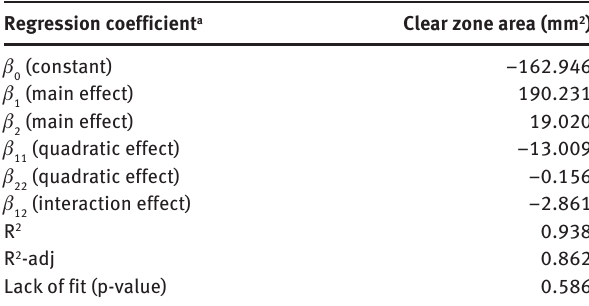
Table 2: Regression coefficients (R 2 ), adjusted R 2 (R 2 -adj), and probability values for the model.